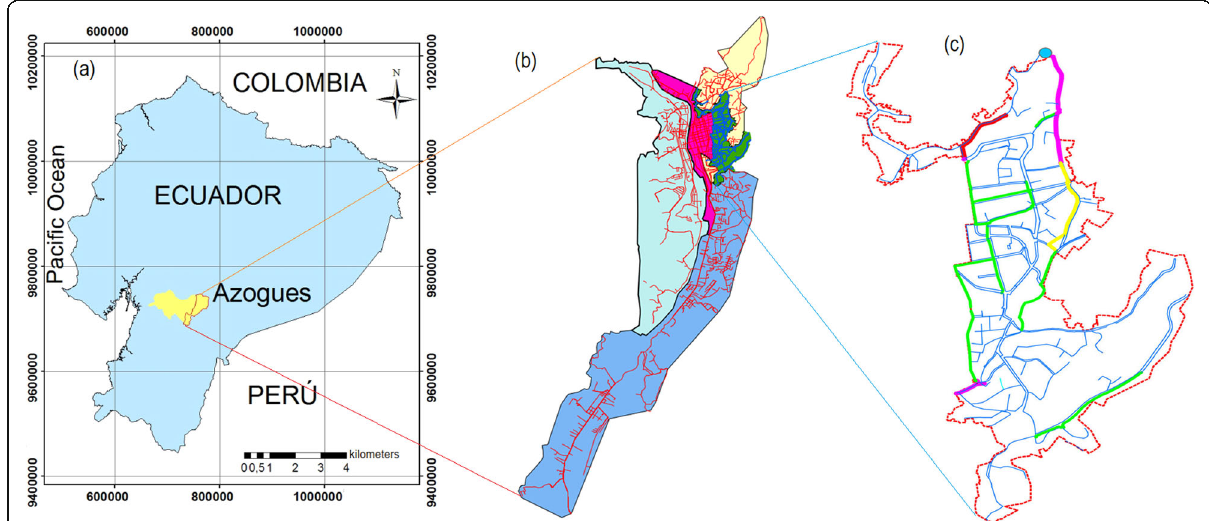
Fig. 1 Location of the study area. a Location of the Azogues city, Republic of Ecuador. The coordinate reference system is WGS84/UTM zone 17S EPSG 32717 b Total drinking water network in the city, c Drinking water distribution network chosen for the